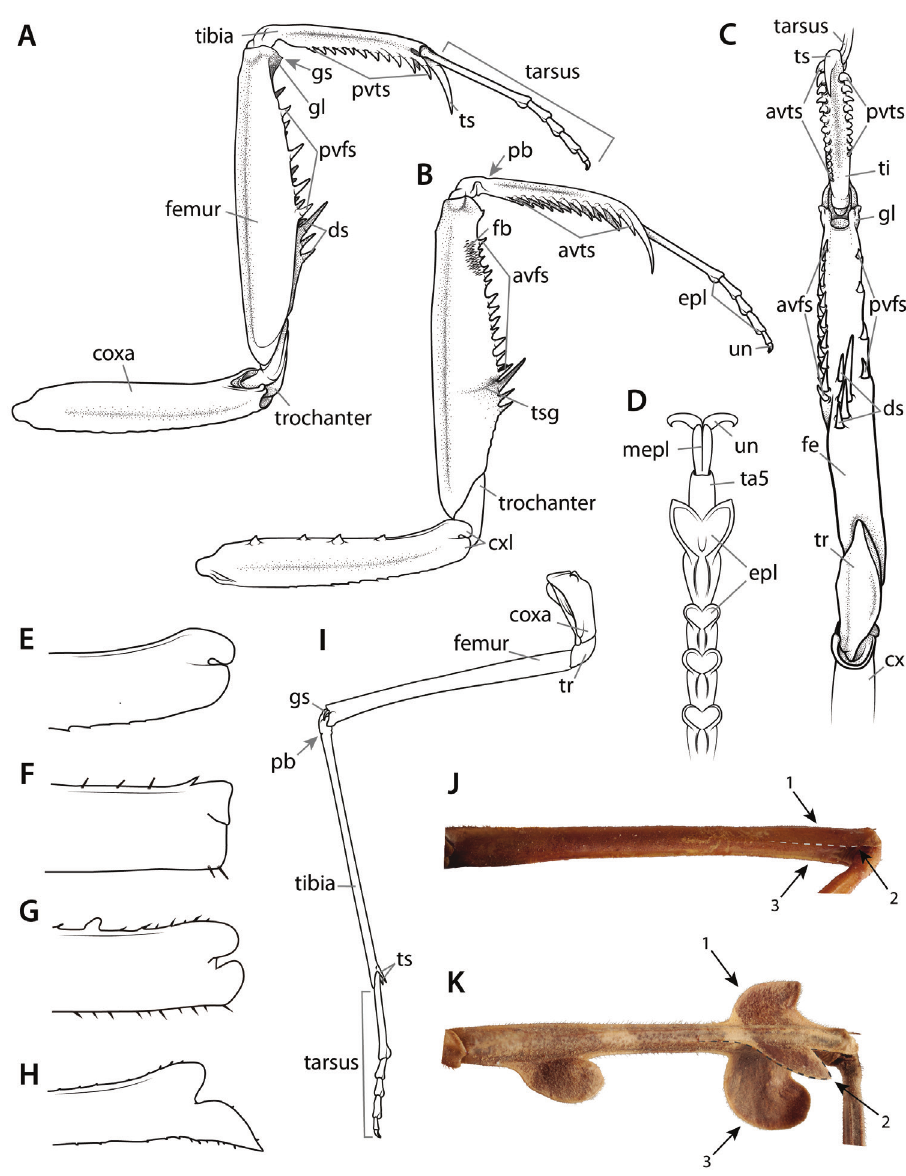
Figure 6. Continued. Example of the cuticular lobes that can project from leg carinae K Alangularis mul- tilobata (Chopard, 1910) ♀ : ventral view 1 = anterodorsal metafemoral lobe; 2 = anteroventral metafemoral lobe; 3 = posteroventral metafemoral lobe. Dashed lines demarcate anteroventral carinae ( J ) and associated lobes ( K ). Abbreviations: avfs = anteroventral femoral spines; avts = anteroventral tibial spines; cx = coxa; cxl = coxal lobes; ds = discoidal spines; epl = euplantulae; fb = femoral brush; fe = femur; gl = genicular lobe; gs = genicular spur; mepl = medial euplantula; pb = proximal bend in the tibia; pvfs = posteroventral femoral spines; pvts = posteroventral tibial spines; ta5 = tarsomere 5; ti = tibia; tr = trochanter; ts = tibial spur; tsg = tibial spur groove; un =